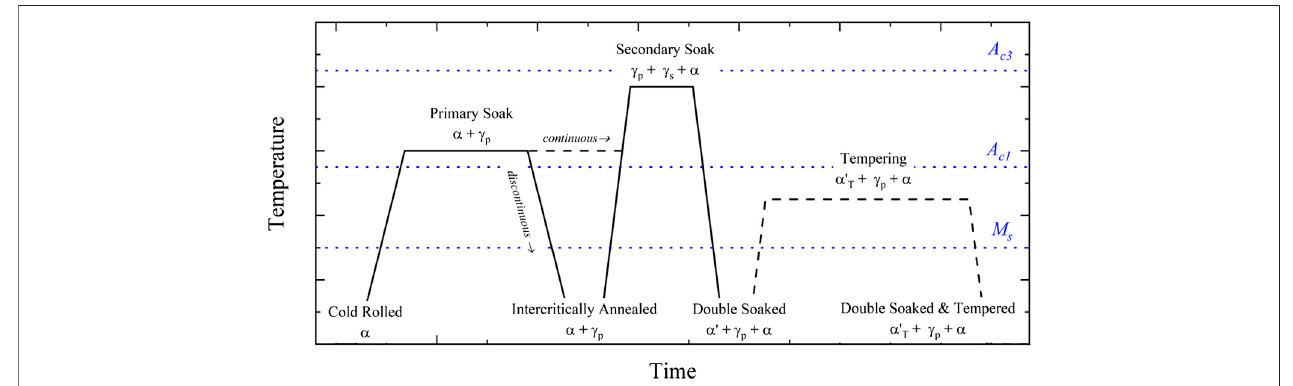
FIGURE1| Schematicofthedoublesoakingplustempering(DS-T)heattreatment.Expectedchangesinmicrostructureareindicated:ferrite( α ),primaryaustenite ( c P ), secondary austenite ( c s ), martensite ( α ′ ) and tempered martensite ( α ′ T ).